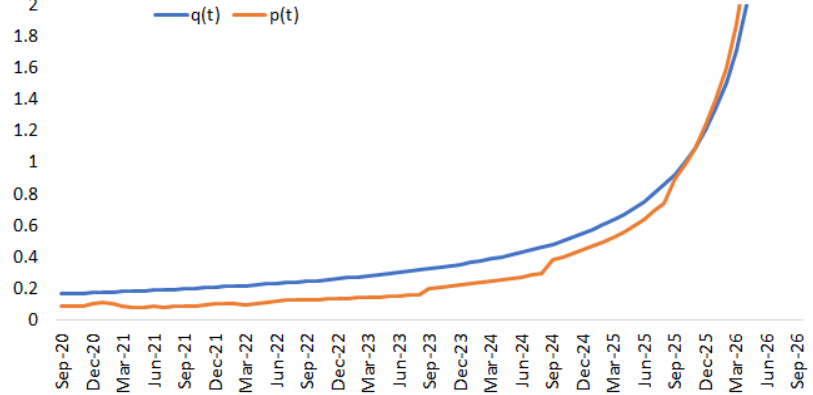
Figure 8. “Short-rate-like” and “dividend-like” parameters q ( t ) and p ( t ) of the process (99) (stripped from yield curve data as of 28 September 2020). Note: p ( t ) = f T = 6; plot truncated due to explosive behavior of p with t → T ; q ( 6 ) =